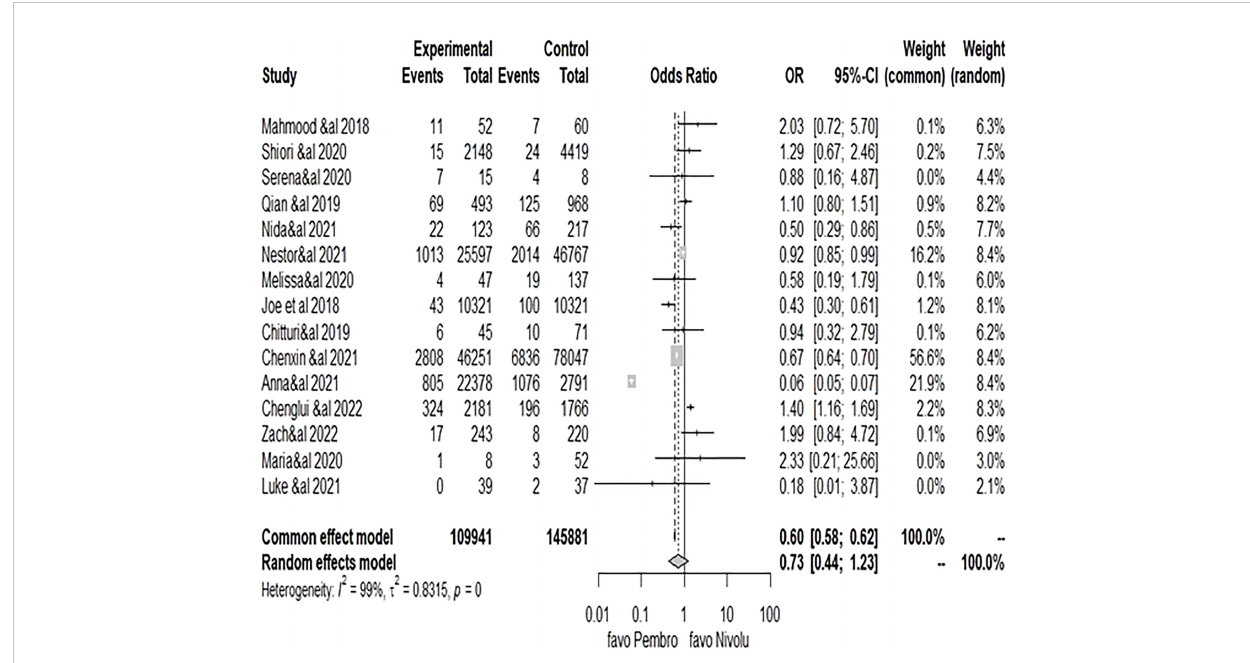
FIGURE 3 Forest plot of comparison of pembrolizumab vs. nivolumab, outcome: 1.1 cardiotoxicity odds ratio.